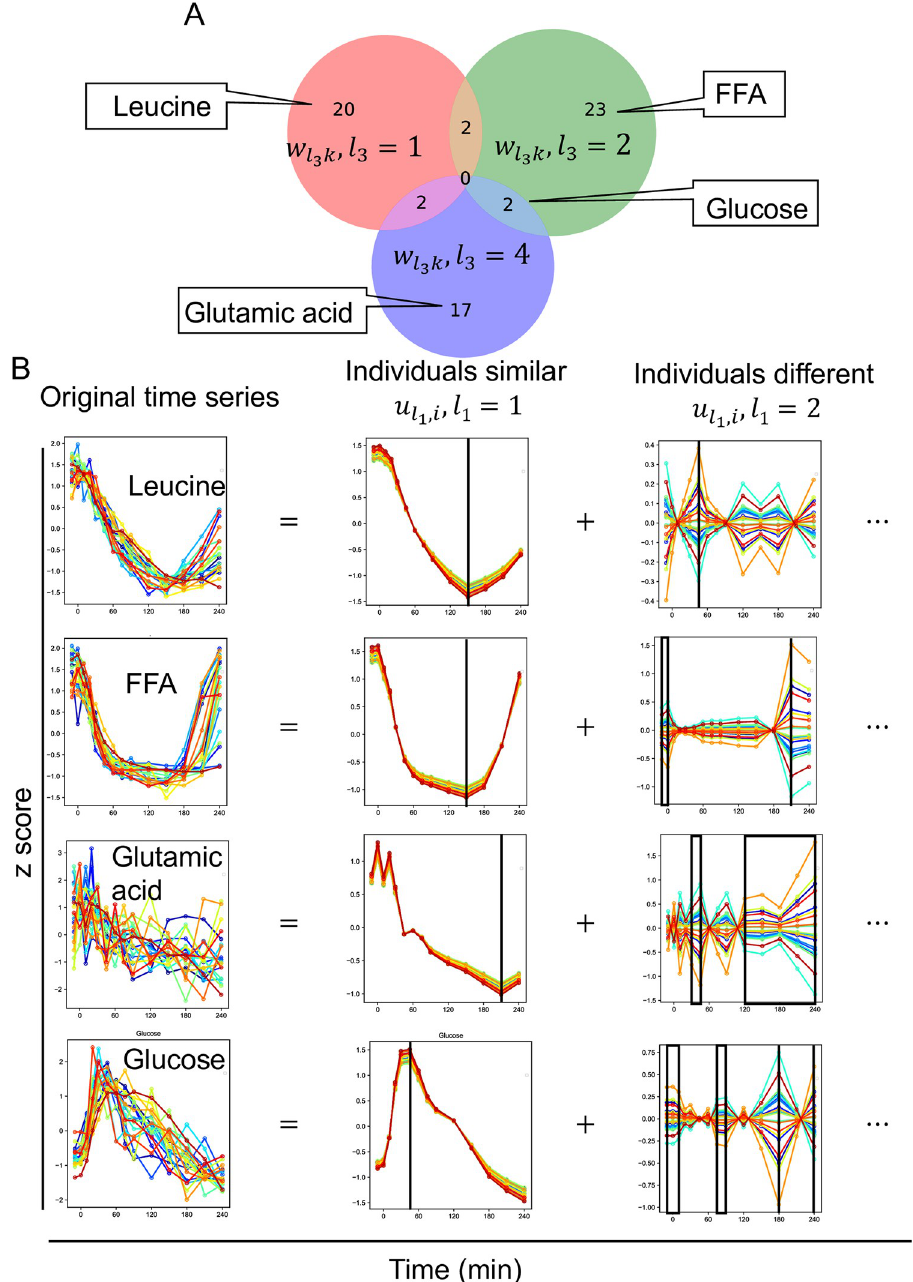
Fig 3. Set of molecules selected by tensor decomposition and decomposed time series by the dominant singular vectors ( ‘third-order tensor with individuals mode , time mode , and molecule mode’ ). A Venn diagram of the set of molecules selected by tensor decomposition. These sets include the molecules whose time series are shown in B. B Decomposed time series by the dominant singular vectors. Decomposed time series by other than the dominant singular vectors ( u ; l > 2 Þ are omitted. The black lines in “individuals similar” indicate the time point of the peak. l 1 i 1 The black boxes and black lines in “individuals different” indicate time points of high variability among individuals. The color of each line indicates each individual. Abbreviations for the molecule are as follows: FFA, free fatty acid.